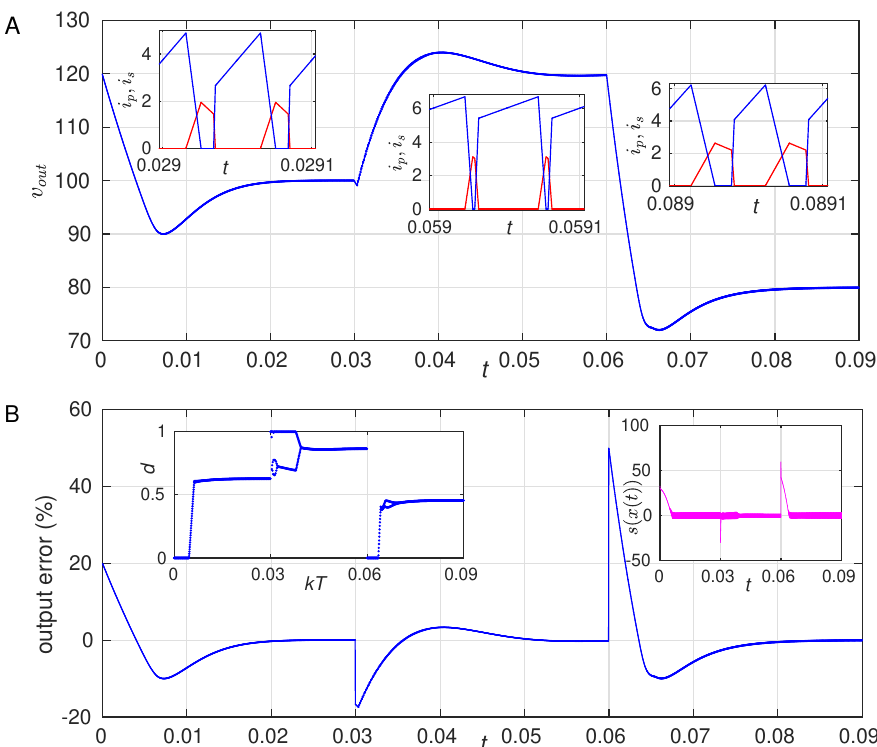
Figure 9. ( A ). Main panel: output voltage as function of time with disturbances performed at the reference voltage, the input voltage and the load simultaneously. The disturbances are applied at t = 30 ms and t = 60 ms according to the description in the main text. Insets: Primary (secondary) currents depicted in blue (red) during the steady operation after the transitions. ( B ). Main panel: output error for the disturbances in ( A ). Insets: duty cycle evolution (left) and time series over the whole interval of the function s ( x ( t )) (right). The parameters, as in Table